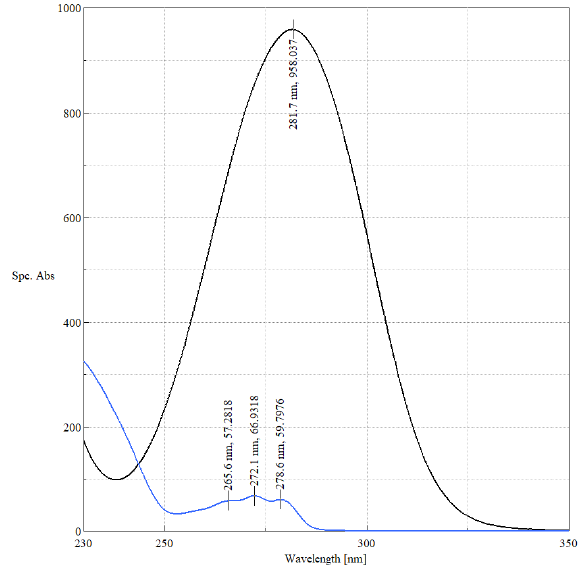
Figure 7. Specific absorptions of fenbufen (black) and fenoprofen calcium (blue) in methanolic solutions with extrema.